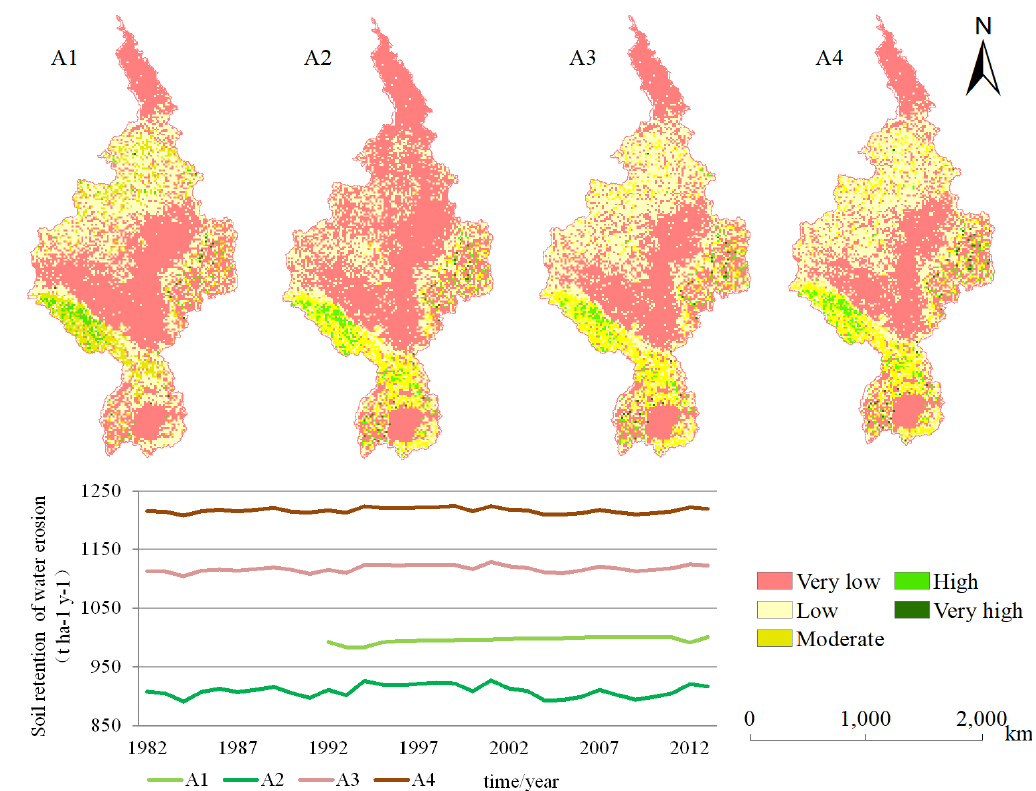
Figure 5. Spatial distribution of the average annual soil retention service and temporal tendency of the average annual soil retention based on four vegetation cover types and management factors